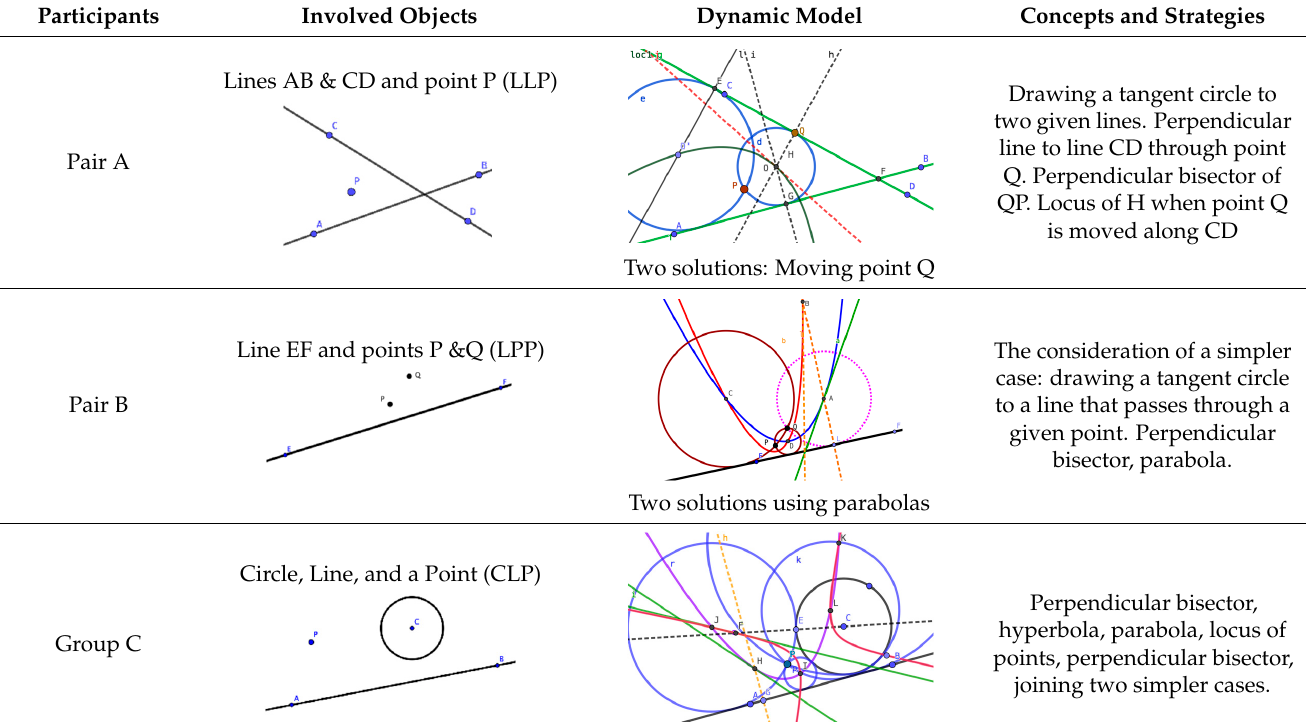
Table 2. Examples of participants’ dynamic models of the tasks .